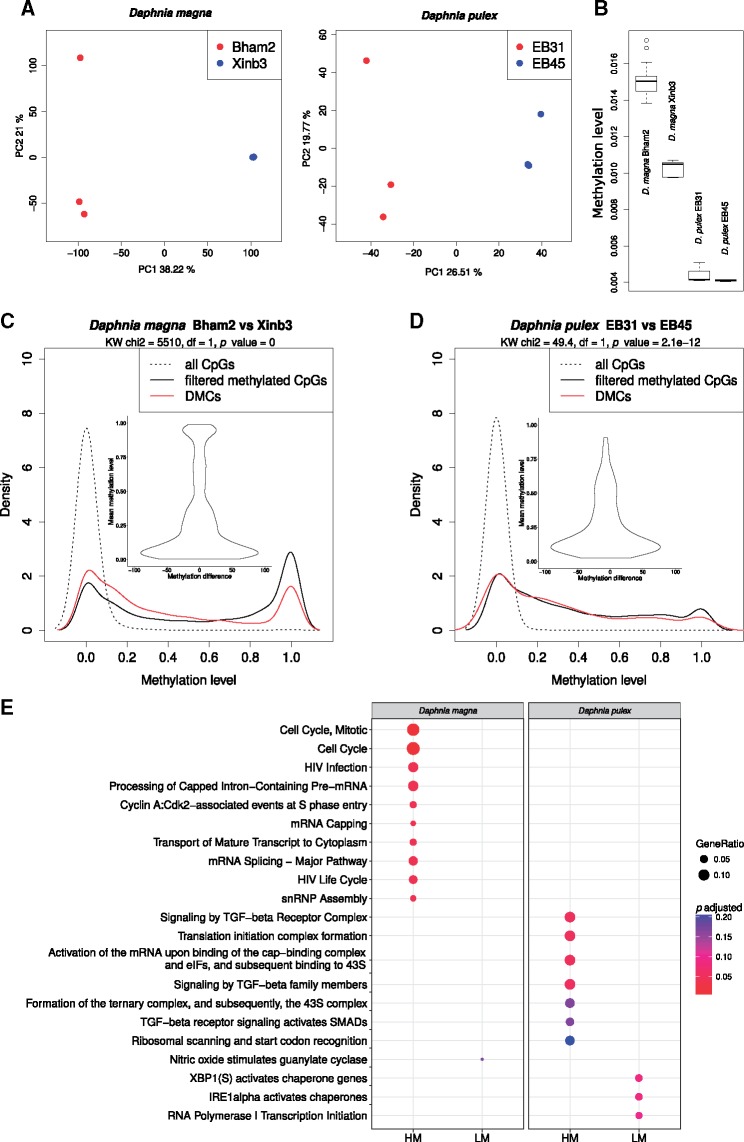
—Differential methylation between strains of D. magna (Bham2 vs. Xinb3) and genotypes of D. pulex (EB31 vs. EB45). (A) Principal component analysis (PCA) of methylation levels in D. magna strains Xinb3 and Bham2, and in D. pulex genotypes EB31 and EB34, using a filtered data set; CpGs with low coverage (<3 reads in each sample) or extremely low methylation levels (<2 methylated reads in at least half of the samples) were excluded. Only age matched control samples were used in each comparison (n = 6). (B) Boxplot of global methylation level in D. magna (Bham2 and Xinb3 strains) and D. pulex (EB31 and EB45 genotypes). (C) Density plot of methylation levels of the DMCs (red), contrasted to both unfiltered CpGs (dashed line) as well as filtered CpGs (solid black). The violin plots within the density plots show the magnitude of difference relative to the methylation level in the DMC sites. (E) Enrichment analysis of DMCs among D. magna strains (Bham2 vs. Xinb3) and D. pulex genotypes (EB31 vs. EB45). The analysis was performed separately for the genes containing high methylated CpGs (HM) and genes containing exclusively LM CpGs in the two different species.